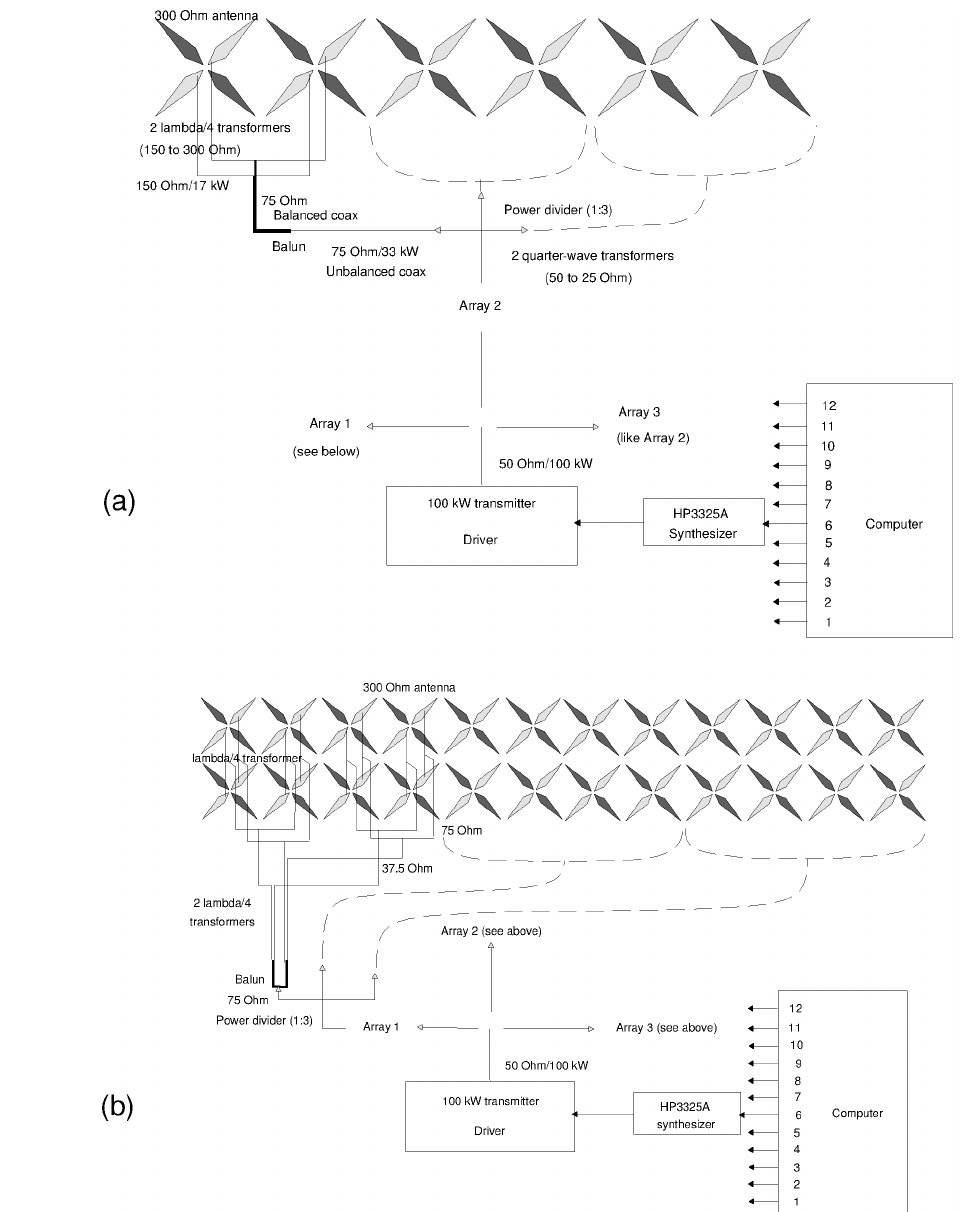
Figure 5. Diagram showing the transmission system and how the power was distributed from one transmitter (a) to six crossed dipoles in each of the antenna arrays before the storm in 1985 and (b) to 24 crossed dipoles in the rebuilt Array 1 from 1990. After 2008, the HP3325A synthesizers were replaced by direct digital synthesizer